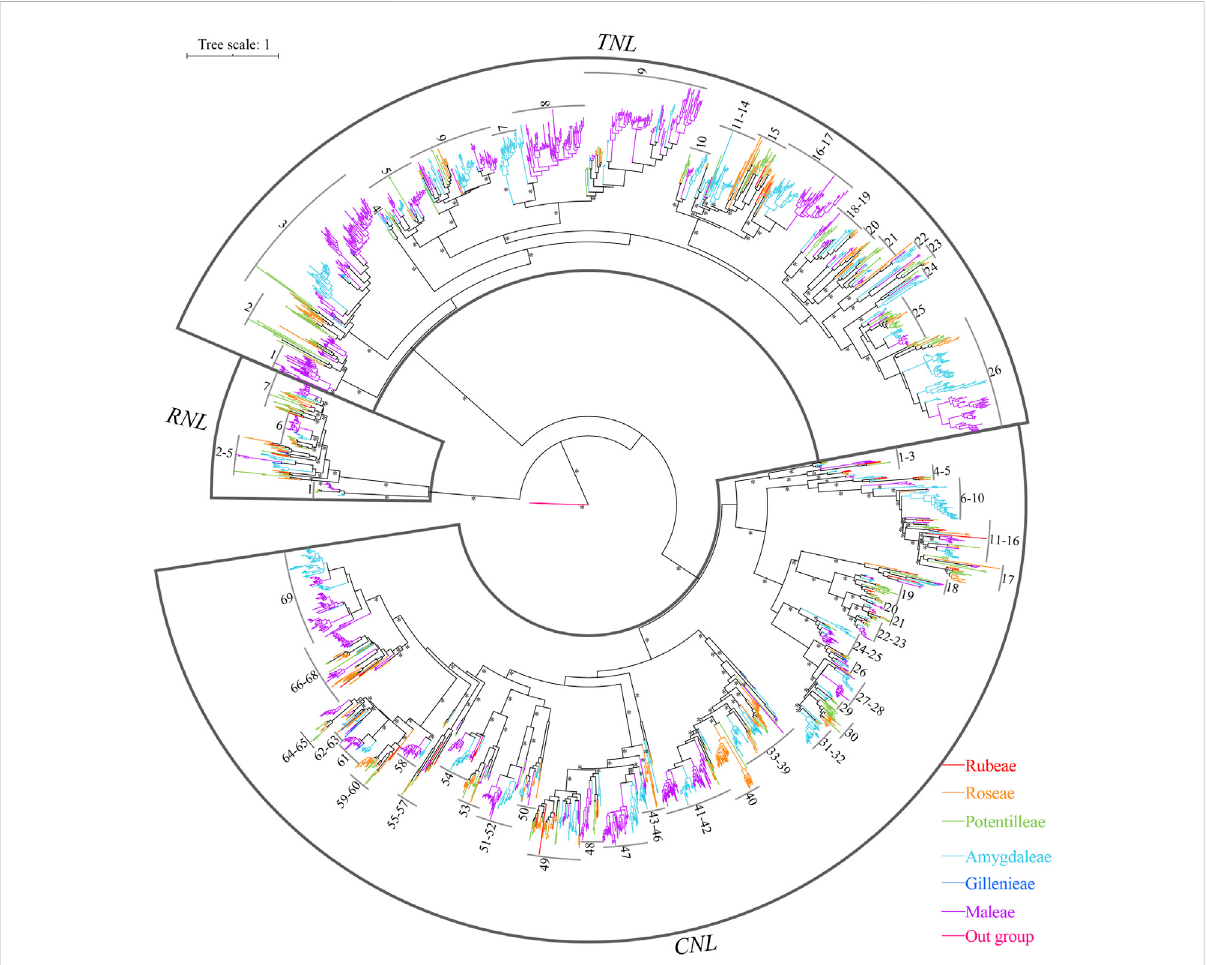
FIGURE 3 Phylogenetic relationships of NBS-LRR genes from Rosaceae genomes. NBS-LRR genes from distinctive plant tribes are indicated by different colors. Branch support values > 70% for basal nodes are indicated by an asterisk (*). The detailed phylogenetic trees are shown in Supplementary Figures S1,